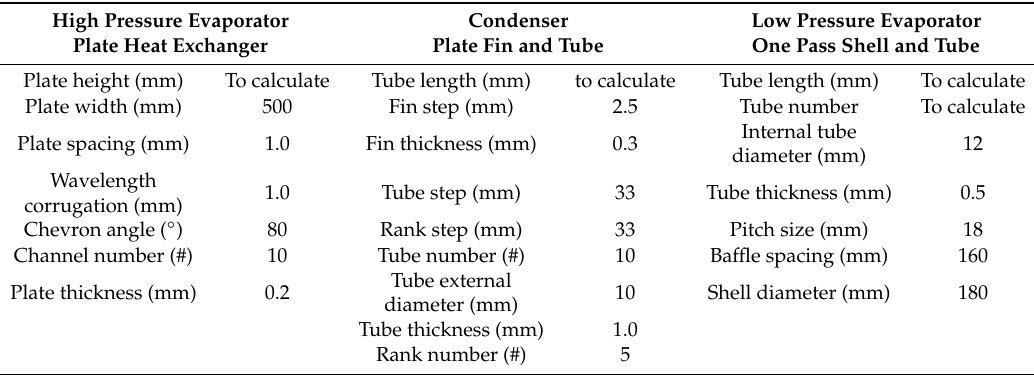
Table A7. Main sizing parameters of the heat